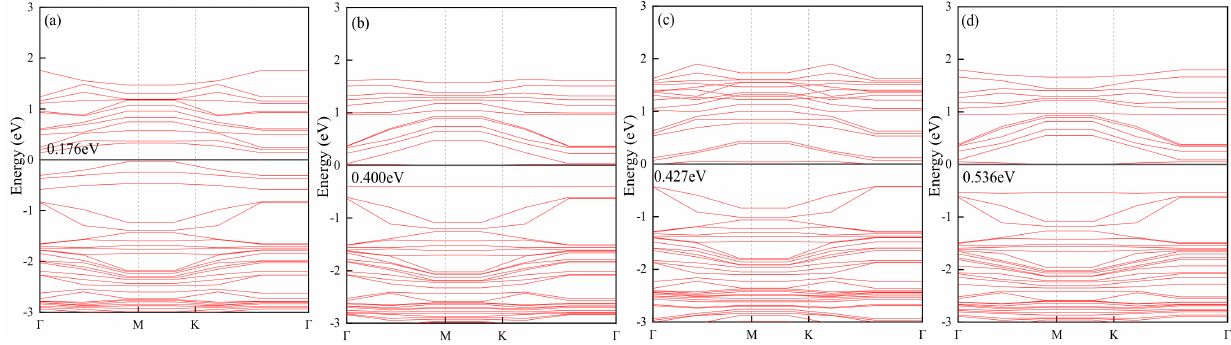
Figure 9. Band structures of Ti − HfSe 2 and each adsorption system. ( a ) Ti − HfSe 2 ; ( b ) CO 2 ; ( c ) CH 4 ; ( d ) N 2